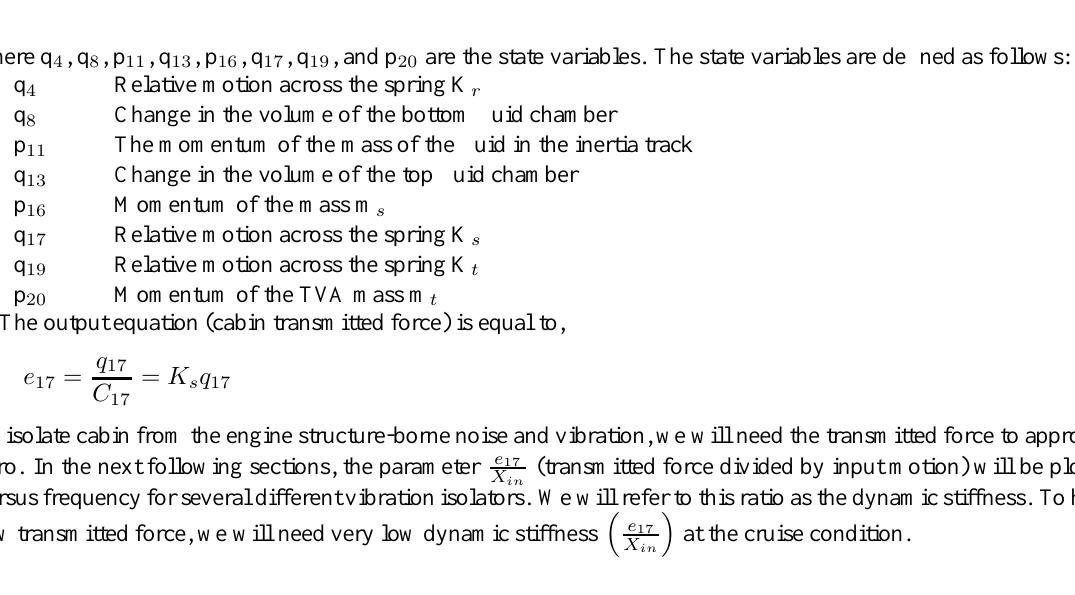
Fig. 9. Bond graph model of Fig.